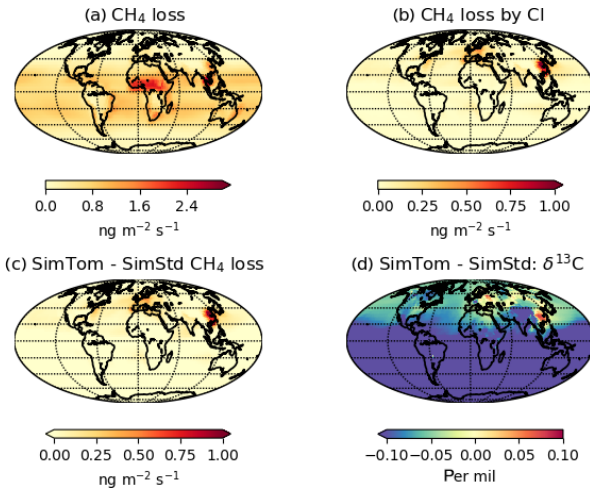
Figure 10. The seasonal cycle of δ 13 C of CH 4 at the SPO site with the annual mean removed averaged over 2002–2004 for the GMD observations (black), SimStd (red), SimGC (blue), SimTom (cyan), SimMBL (orange), SimWet (green), and SimOHp (purple). Error bars represent the standard error, calculated as the maximum of the pooled standard deviation or the analytical uncertainty (0.06‰), divided by the square root of the number of years of